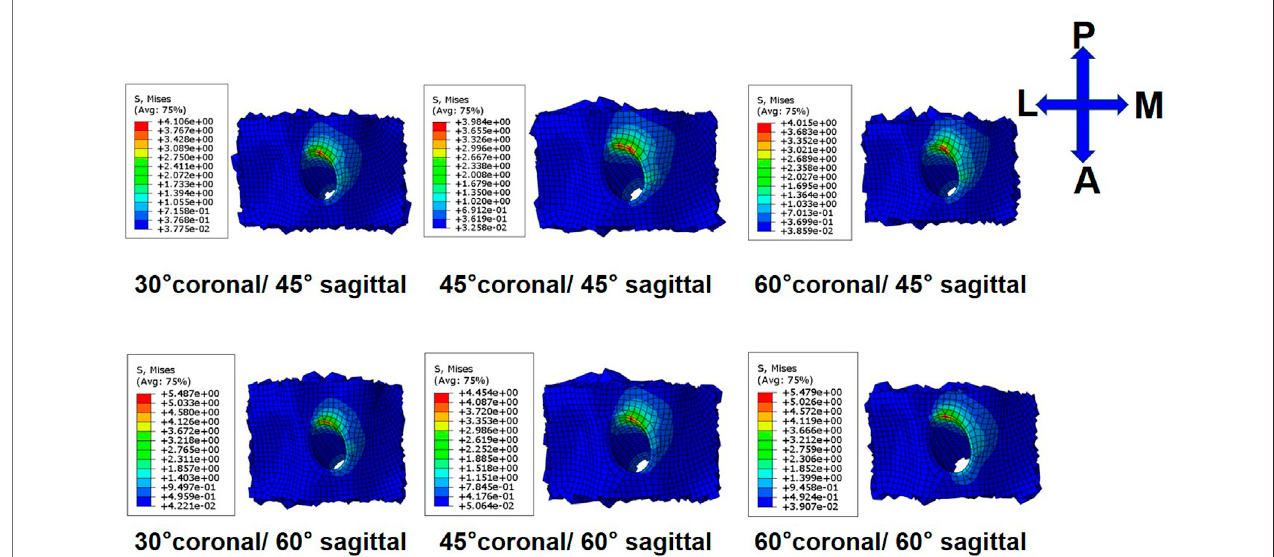
FIGURE 6 | Stress distribution around tibial tunnel entrance following ACLR.